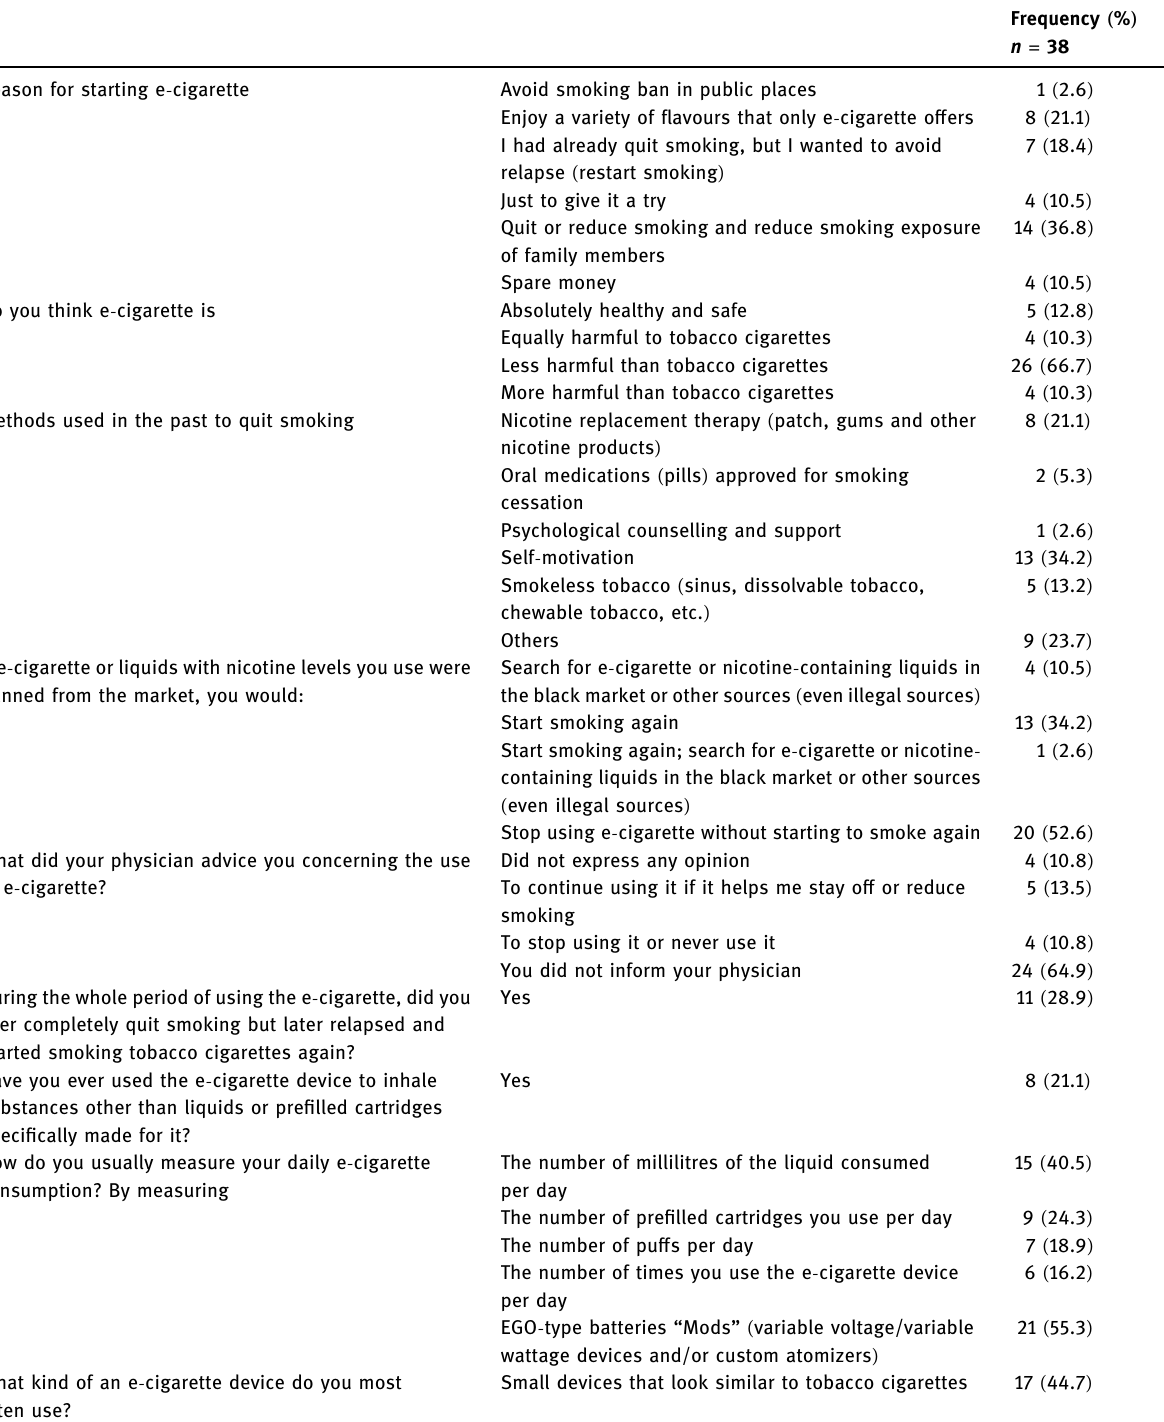
Table 1: Awareness of e - cigarette usage and e ff ects in 38 cases using frequency distribution ( questions modi fi ed from Farsalinos et al. [ 2 ])